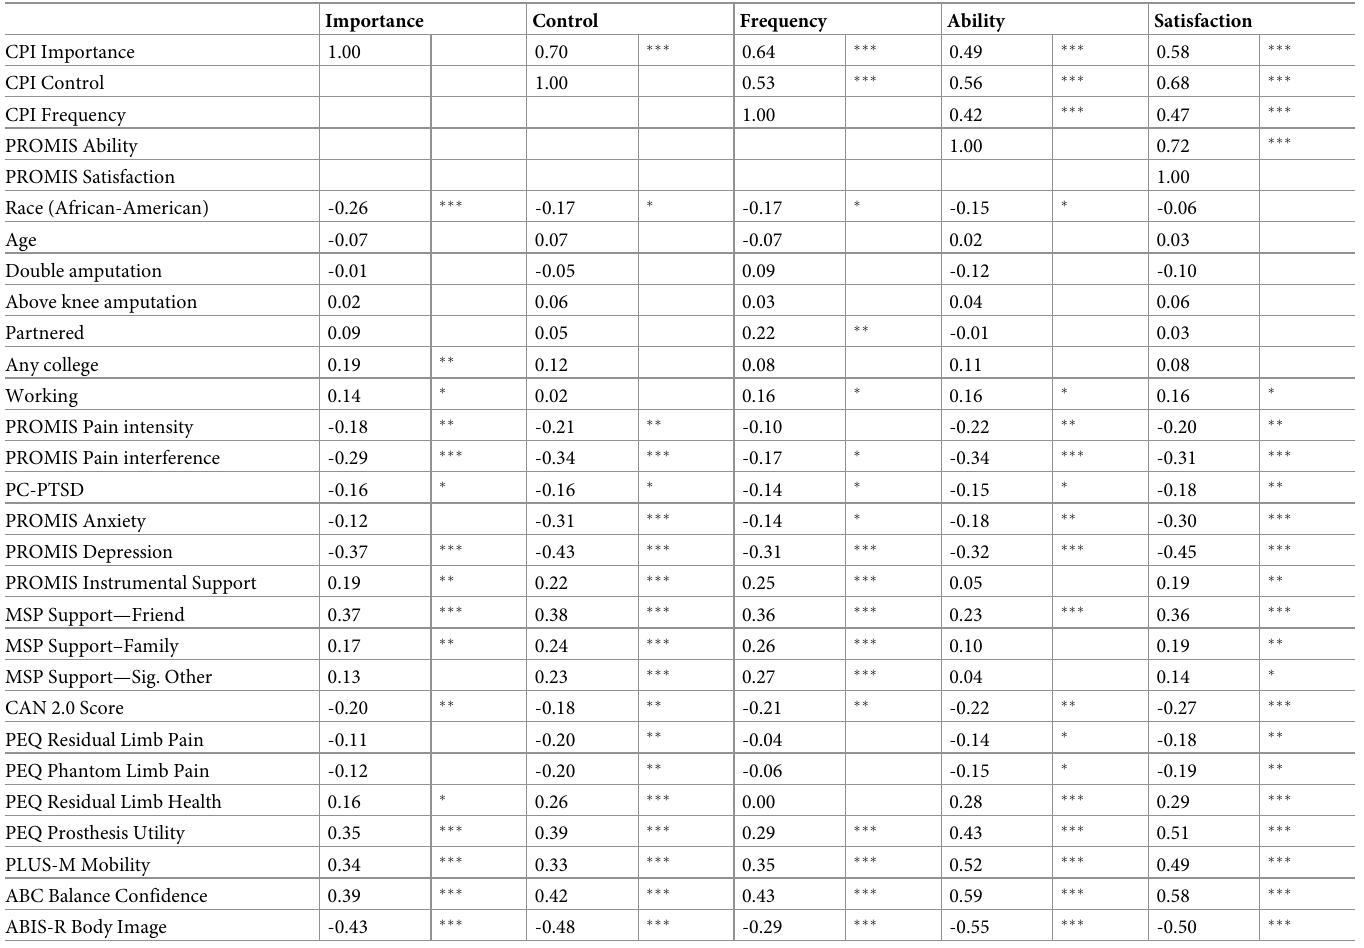
Table 3. Correlations of participation indicators with